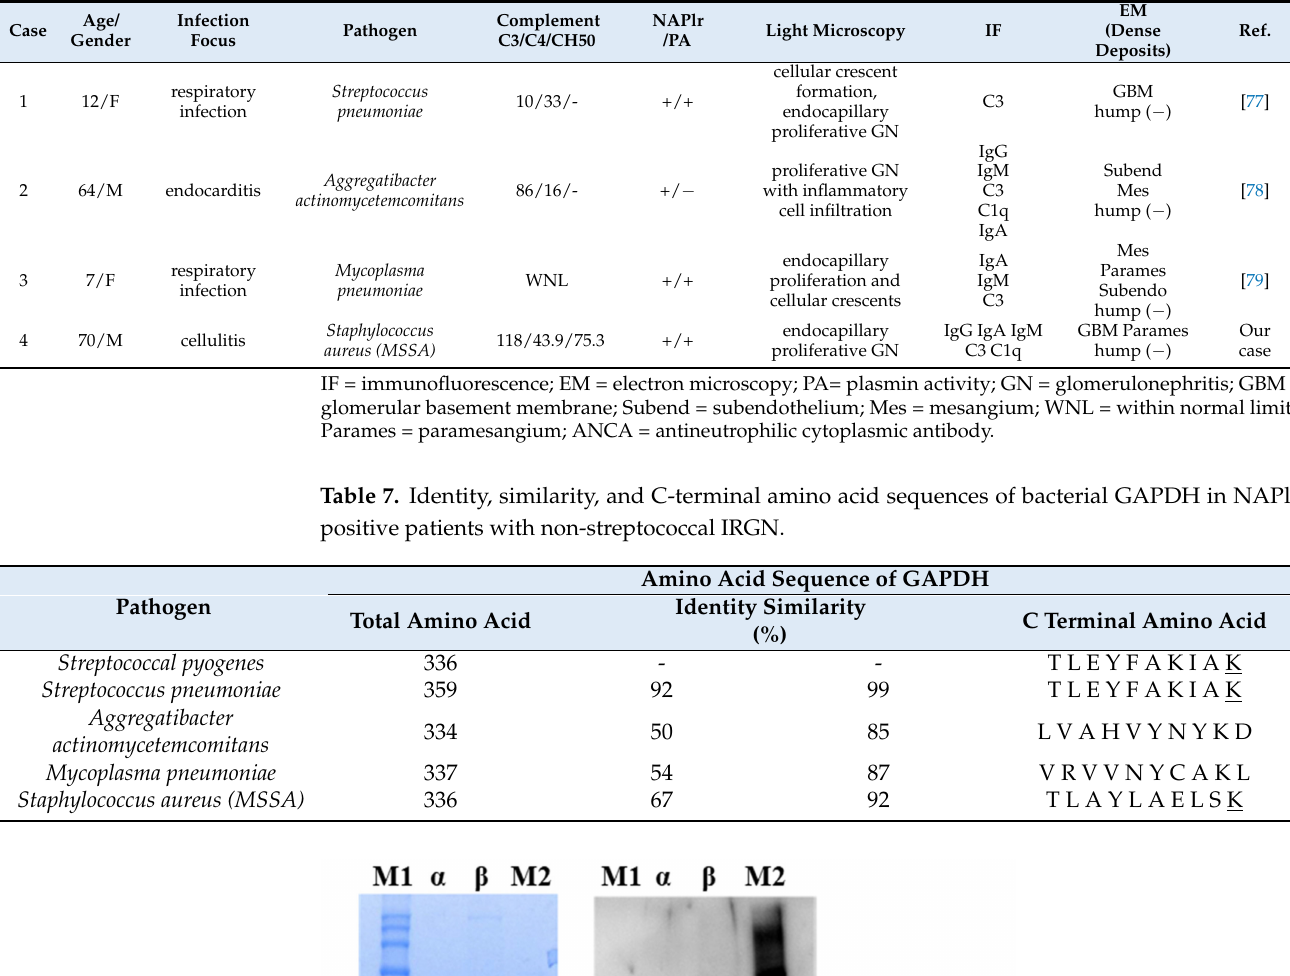
Table 6. Clinical and pathological profiles in patients with NAPlr-positive non-streptococcal IRGN.